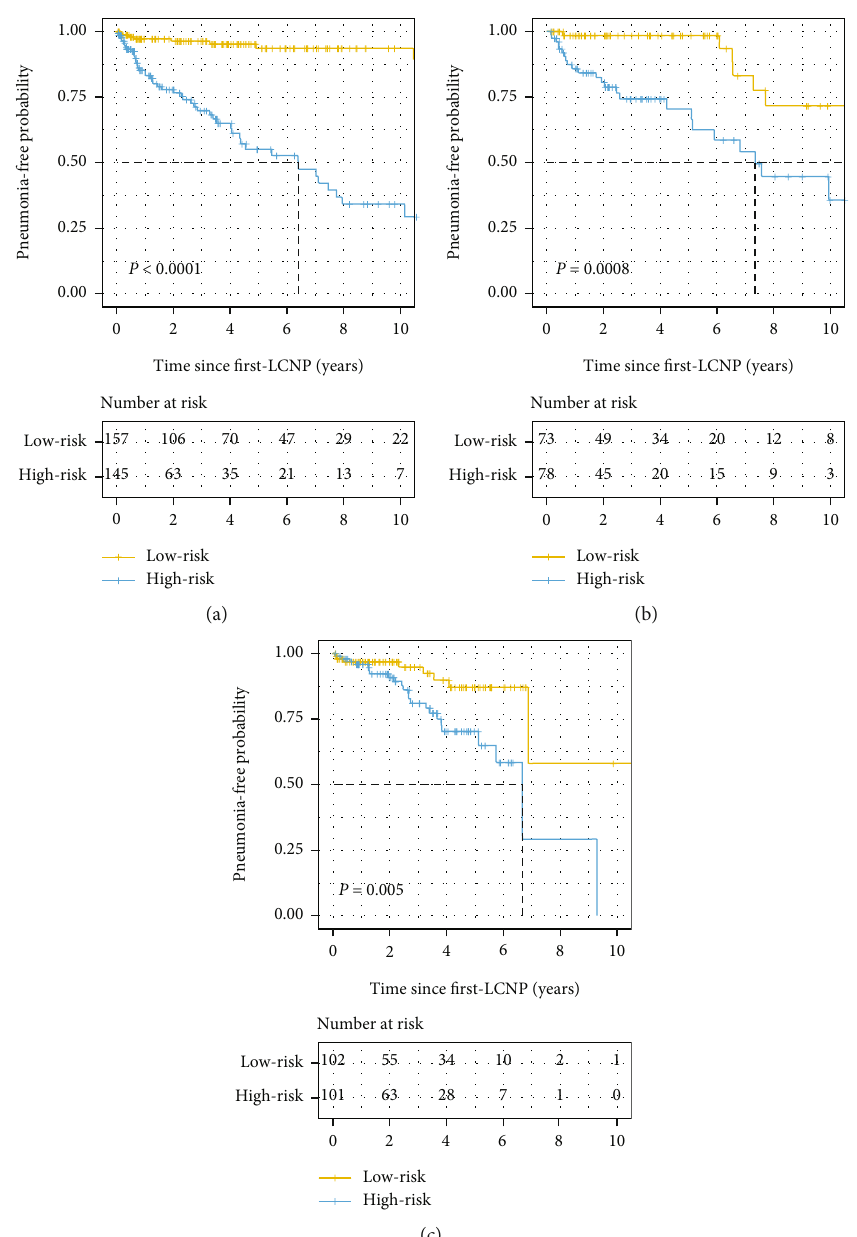
Figure 3: Kaplan – Meier survival curves of the cohorts categorized into low- and high-risk groups. A signi fi cant association between the risk score and PFS was observed using the training cohort (a) and con fi rmed using the internal (b) and external validation cohorts (c). Abbreviations: PFS: pneumonia-free